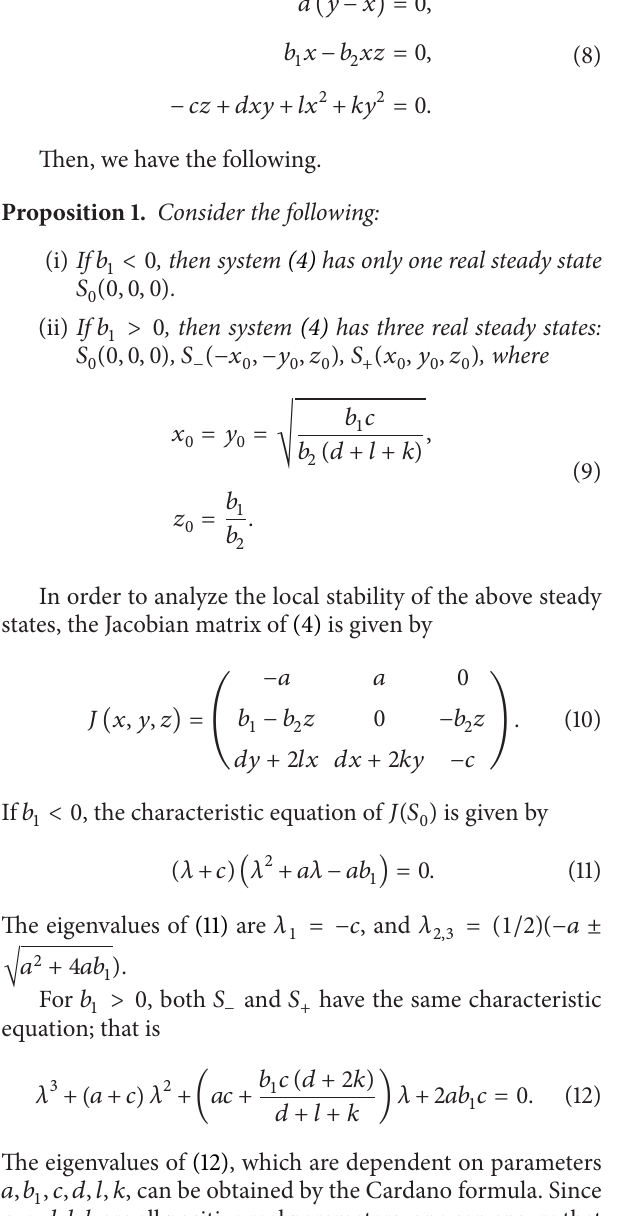
Figure 3: The steady state 𝑆 − of system (4) is locally asymptotically stable when 𝑏 1 < 𝑏 𝑐